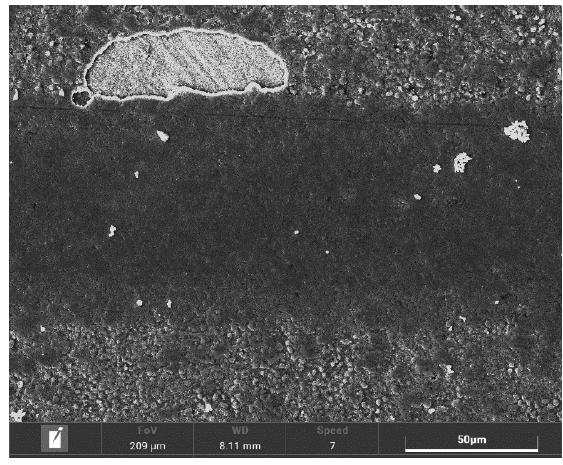
Figure 9. Spalling of the white layer; gaseous ferritic nitrocarburized surface; and load = 15 N. Magnification, 1000 × .